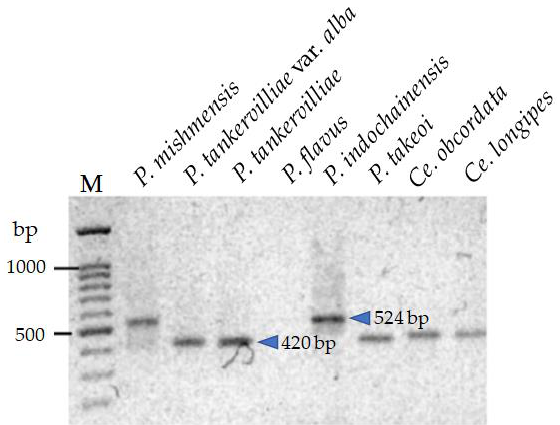
Figure 3. PCR products showed specific bands from different species using Pmis524 SCAR primer, M: 100 bp DNA ladder (Gene Direx, Jhunan Township, Taiwan).